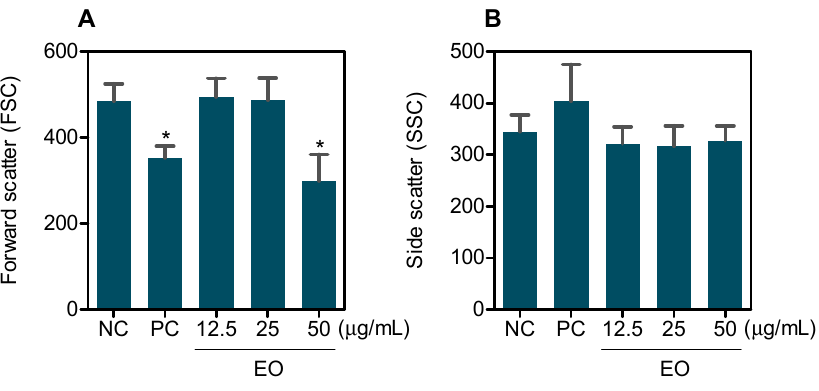
Figure 3. Effect of G. olivacea leaf EO in HepG2 cell morphology, as determined by light-scattering features detected by flow cytometry after 48 h of treatment. ( A ) Forward scatter. ( B ) Side scatter. Negative control ( NC ) was treated with vehicle (0.5% DMSO) used for diluting EO, and doxorubicin (0.5 µ g/mL) was used as positive control ( PC ). Data are presented as mean ± S.E.M. of at least three independent experiments. * p < 0.05 compared with negative control by ANOVA, followed by Student–Newman–Keuls test.